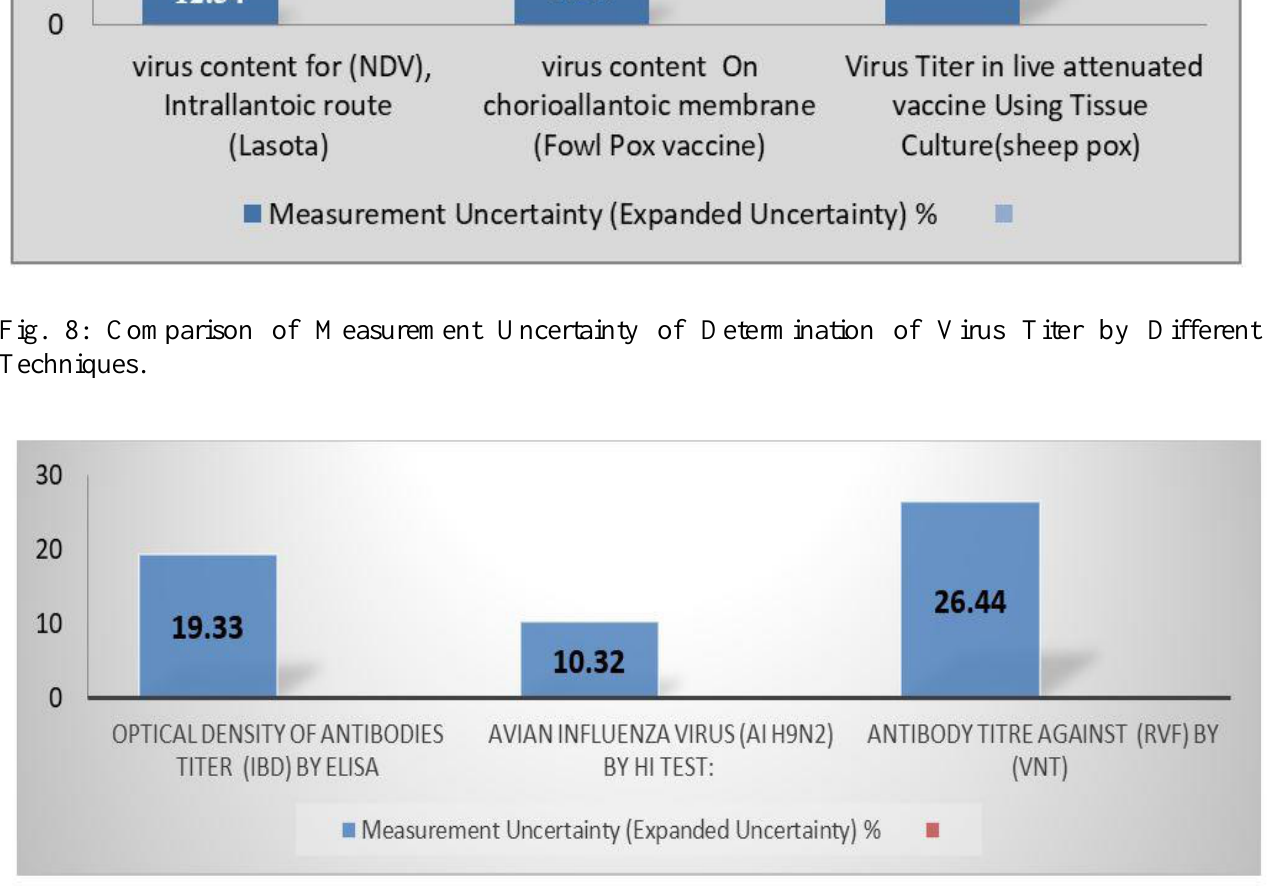
Fig.9: Comparative between Measurement Uncertainty of Determination of Antibody Titer by Different Technique. Table 4: Statistical analysis of component of measurement uncertainty for different